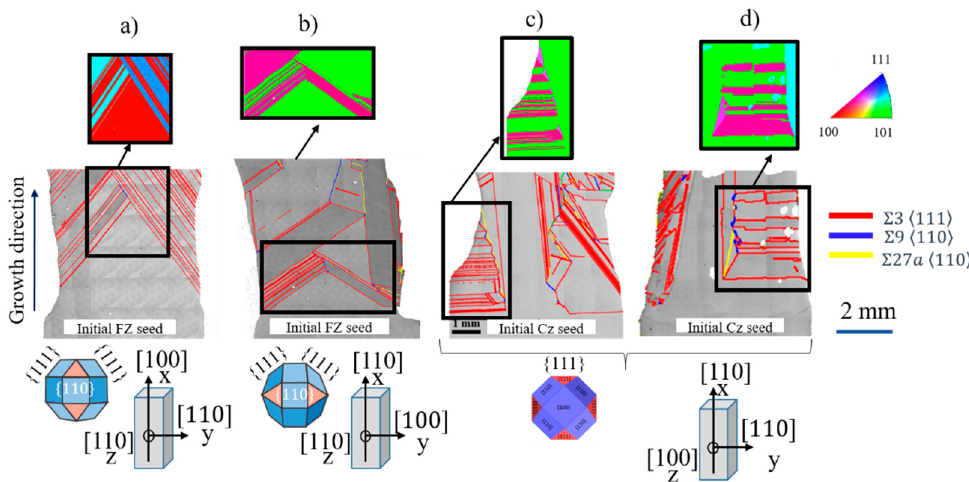
Figure 6. Ex situ electron backscatter di ff raction (EBSD) measurements revealing the grain structure and twin boundaries after growth and cooling down in samples grown from monocrystalline seeds. Applied temperature gradient: 30 K/cm and cooling rate applied on both heaters ( a ) − 1 K/min (same